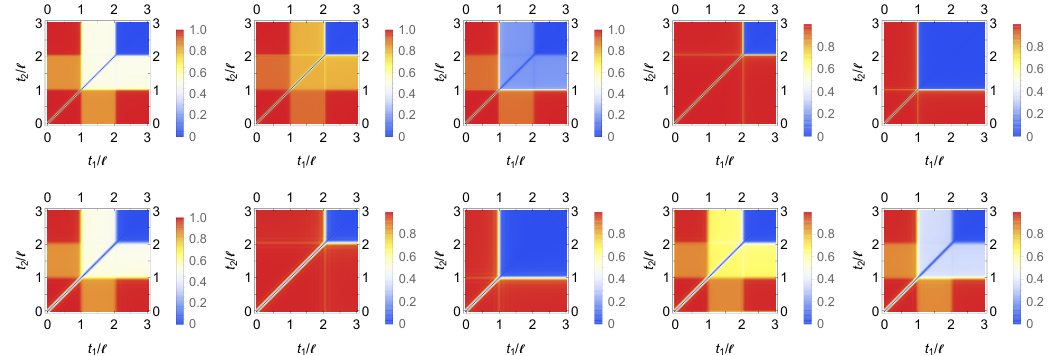
Figure 9 . The second Schatten distance after local operator quench inside the subsystem A = [1 ; 3 ‘ = 96] in spin chains. The operator is always inserted at ‘ = 32. Top: linearized critical Ising chain. From left to right the inserted operators are d 2 j , d 2 j (cid:0) 1 + d 2 j , d 2 j (cid:0) 1 (cid:0) d 2 j , ( j (cid:0) 1 (cid:22) ( j + 1 ), respectively, and the corresponding ratios of the purely anti-holomorphic parts are q = 4 1 ; 1 (cid:0) 1 ; 1 + 1 ; 0 ; 1. Bottom: linearized critical XX chain in zero (cid:12)eld. From left to right the 2 2 (cid:25) 2 (cid:25) inserted operators are a j , e i (cid:30) ( j ) , e i(cid:22) (cid:30) ( j ) , e i (cid:30) ( j ) + e (cid:0) i(cid:22) (cid:30) ( j ) + e (cid:0) i (cid:30) ( j ) , i(e (cid:0) i(cid:22) (cid:30) ( j ) + e (cid:0) i (cid:30) ( j ) (cid:0) e i(cid:22) (cid:30) ( j ) ) with respectively q = 1 ; 0 ; 1 ; 1 ; 2 . These numerical results perfectly match the CFT prediction 2 3 3